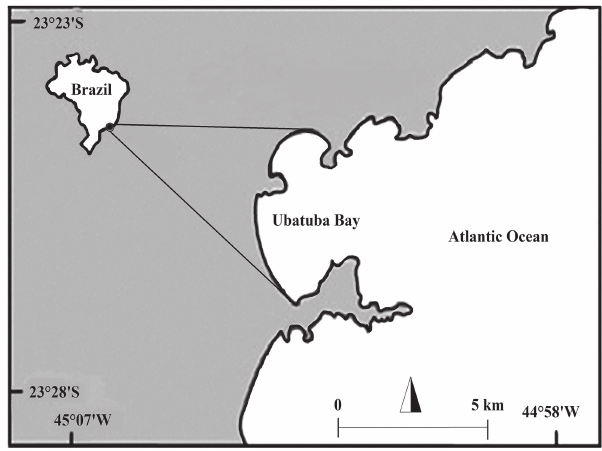
Fig. 1. Study area, Ubatuba Bay in north coast of São Paulo State. Area of artisanal fisheries captures shaded (modified from Santos et al .,